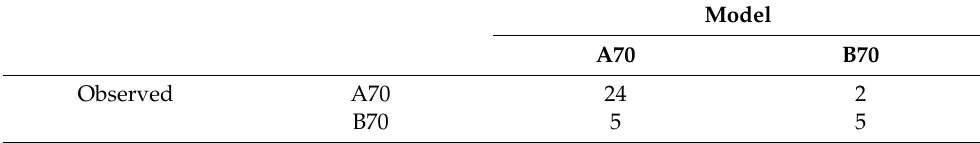
Table 5. Confusion matrix for the test